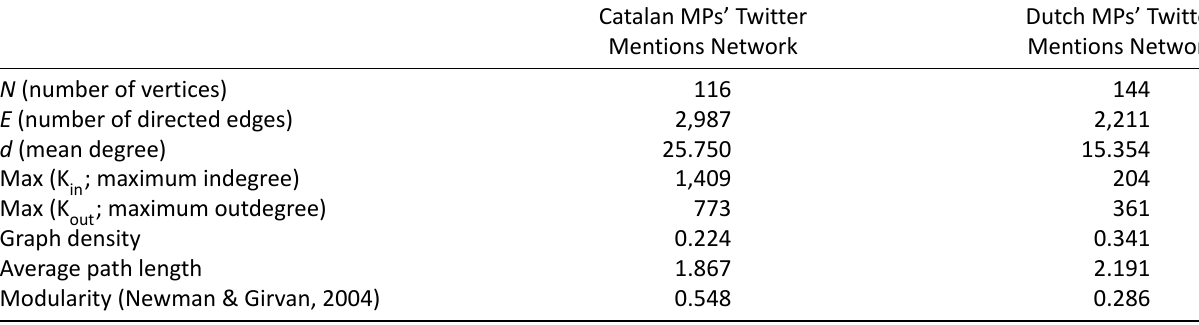
Table 1. Descriptive network statistics of the Catalan and the Dutch MPs’ Twitter mentions